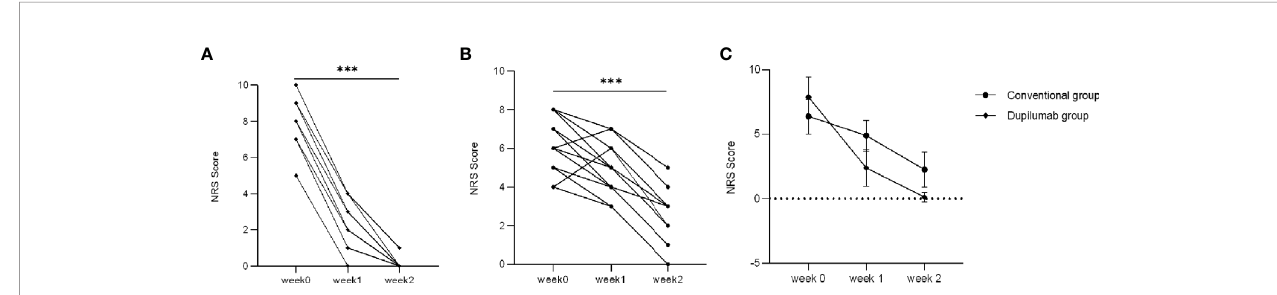
( Figure 4A : dupilumab group, Figure 4B : conventional group; p < 0.001 by Mann-Whitney U test). Consistent with the NRS score data, it has been indicated that patients ’ BPDAI activity score declined more rapidly in the dupilumab group ( Figure 4C , p = 0.0308, two-way RM ANOVA). However, there was no signi fi cant difference between the two groups in BPDAI score from weeks 2 to 32 ( Supplementary Figure 2B ; p > 0.05, two- way RM ANOVA). Only four patients in the dupilumab group had an increased percentage of eosinophils (EOS%) at week 0 (range: 9.6% – 24.8%) while the other four patients ’ EOS% were within the normal range. There were 11 patients in the conventional group with increased EOS% at week 0 (range: 5.4% – 23.5%) while the other fi ve patients ’ EOS% were within the normal range. All patients showed normal EOS% at week 2 in the dupilumab group ( Figure 5A ; p > 0.05, Mann Whitney U test) while two patients retained an increased EOS% in the conventional group ( Figure 5B ; p > 0.05, Mann Whitney U test). There was no signi fi cant difference in decreasing patients ’ EOS% between the dupilumab and conventional groups ( Figure 5C p > 0.05, two-way RM ANOVA).